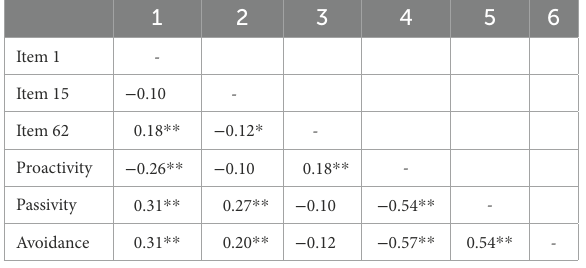
TABLE 7 Correlation between original sources of intentions and three level of actions ( n = 324).